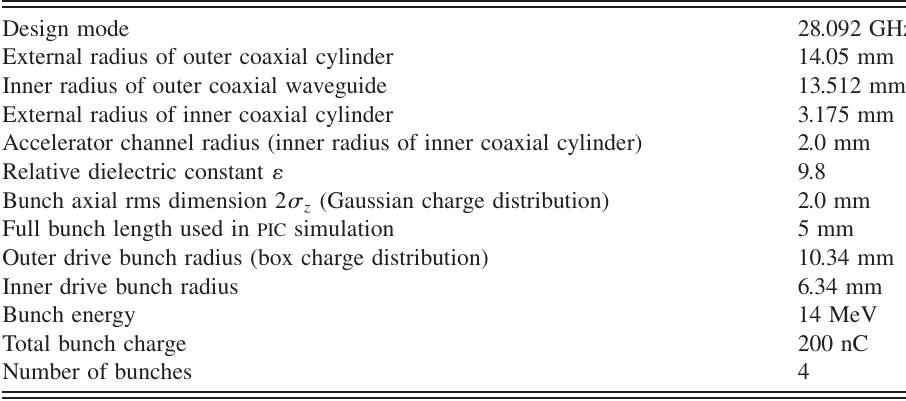
TABLE I. Parameters used for the study of a two-channel CDWA (alumina dielectric).